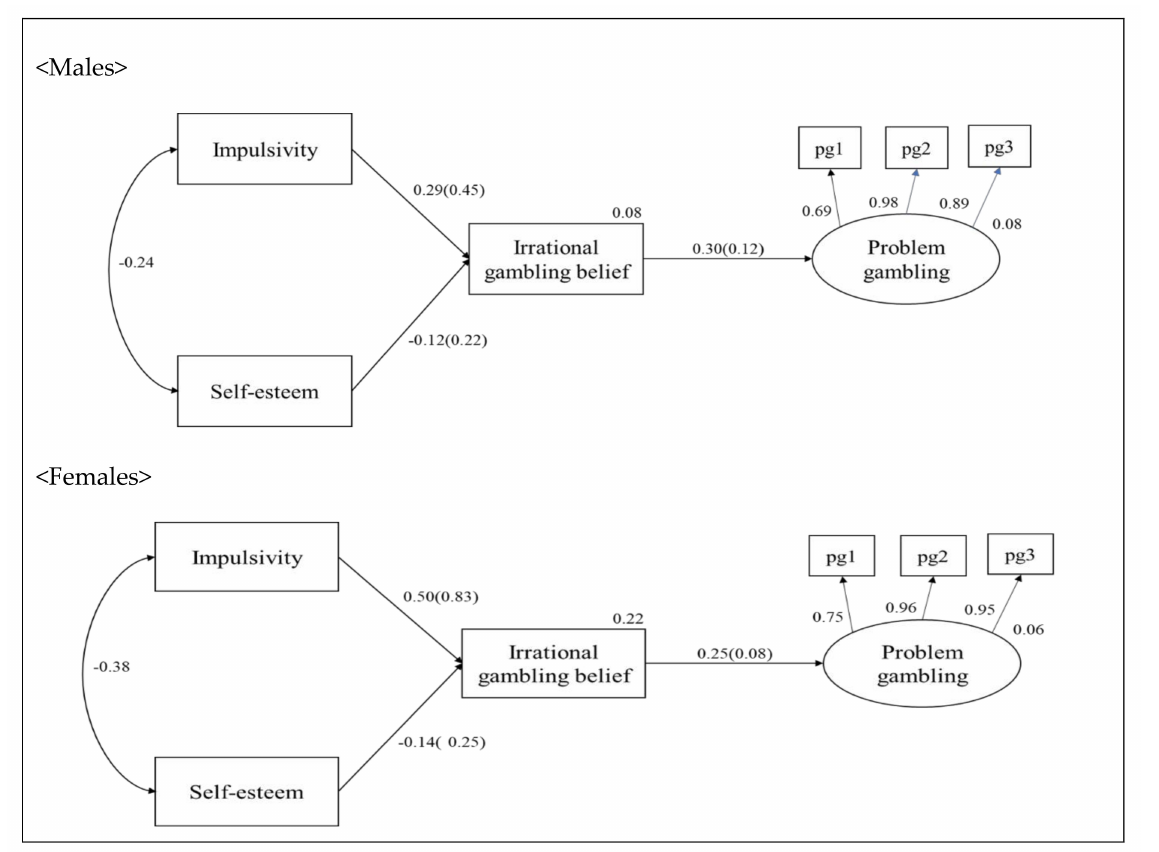
Figure 3. Standardized coefficients (unstandardized coefficients) for a model of the relationship between impulsivity and self-esteem, irrational gambling belief, and problem gambling—estimates for males and females. Note: All coefficients are significant at p <